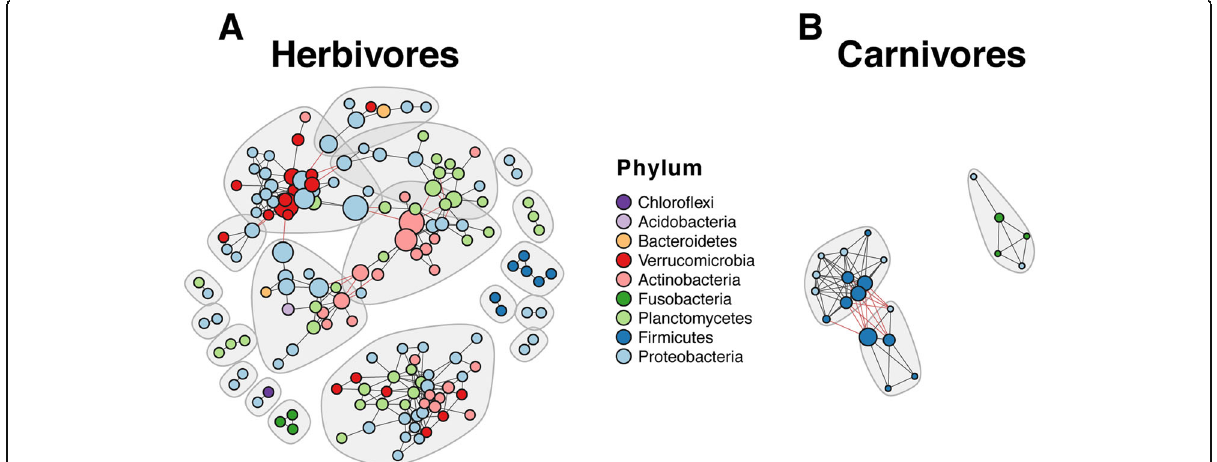
Fig. 4 Diet-specific networks of L. Tanganyika herbivores and carnivores. Nodes are colored according to phylum and sized by betweenness values normalized by lake. Grey shades represent distinct modules (connected by red edges). Notice the higher complexity of the herbivore network (156 nodes and 339 edges; 19 modules) compared to the carnivore network (21 nodes and 70 edges; 3